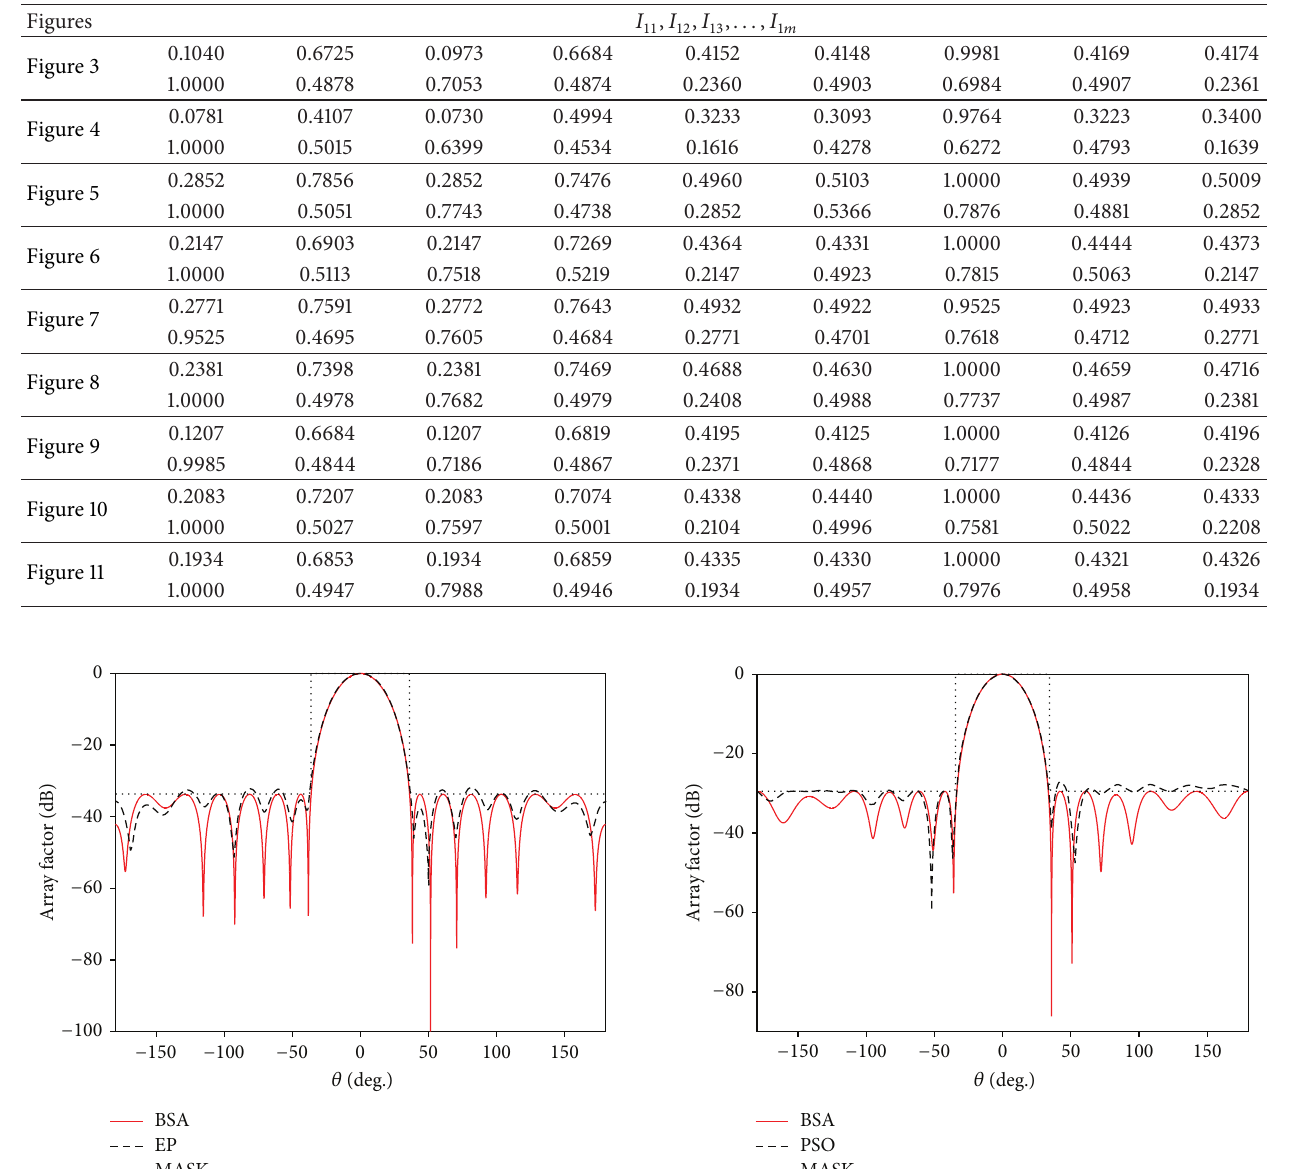
Table 2: The amplitude values calculated by BSA for CCAAs without central element.